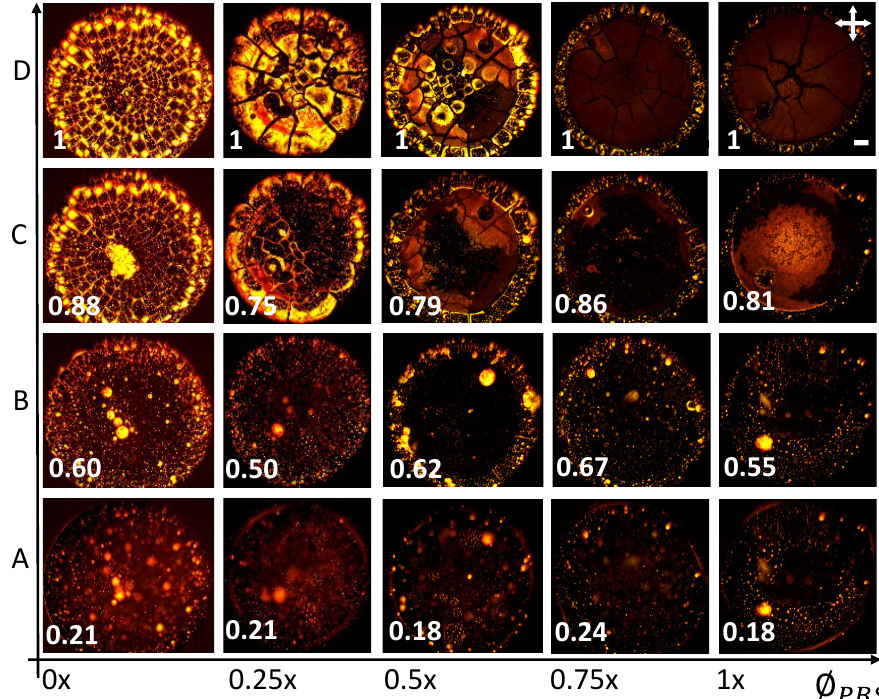
Figure 8. Time-lapse images of drying lysozyme+PBS drop with LC droplets at the initial concentra- tion ( φ PBS ) of 0 to 1 × are displayed in ( A – D ). The timestamps are shown at the bottom left of each image. The images are captured under crossed polarizing configuration (crossed double arrows). The white color in the right corner is a scale bar representing a length of 0.20